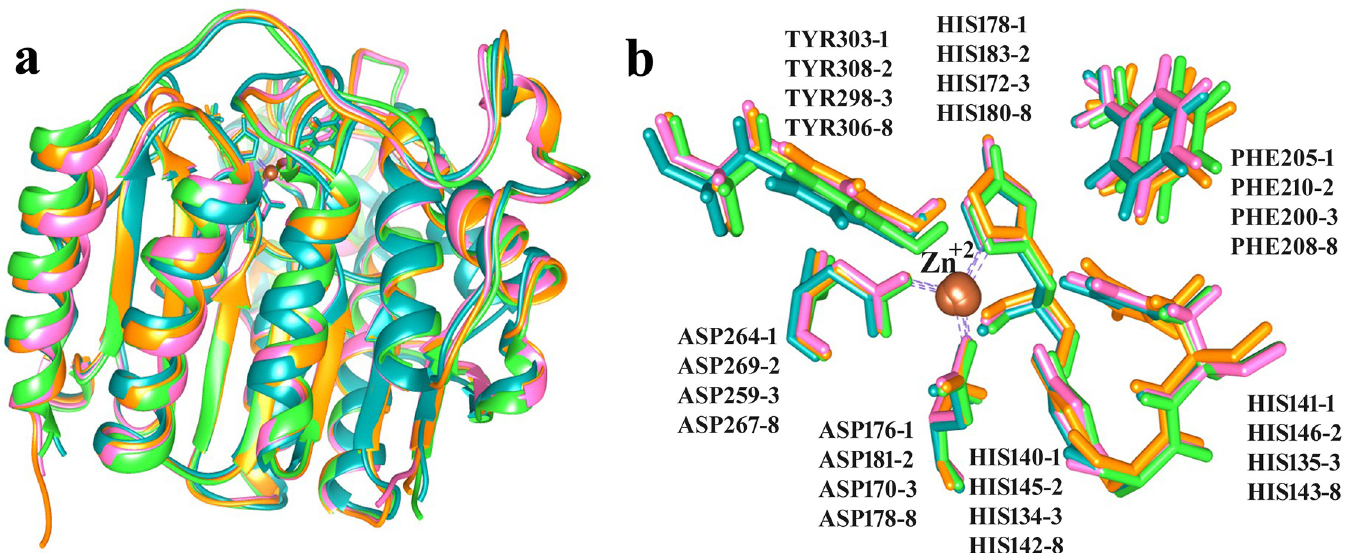
Fig 1. Zn +2 dependent class I HDACs. (a) Structural superimposition of HDACs. (b) Binding sites of class 1 HDACs. HDAC1, 2, 3 and 8 are shown in orange, pink, green and blue, respectively. Zn +2 is shown in brown color.